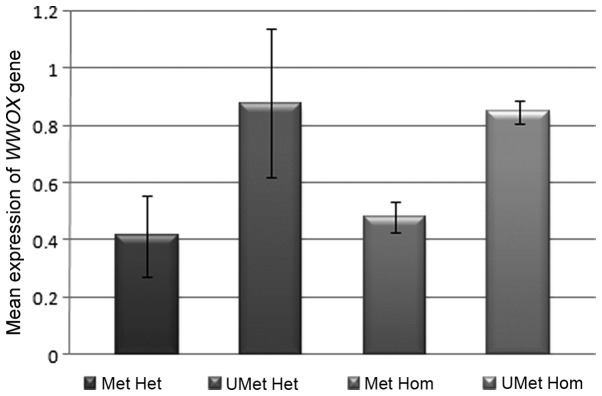
Mean expression levels of the WWOX gene associated with loss of heterozygosity in D16S518 (marker located in intron 1 of the WWOX gene) and the methylation status of the promoter region between −508 and −174 bp (Aspin-Welsch test). Met, methylated; UMet, unmethylated; Het, heterozygous; Hom, homozygous.